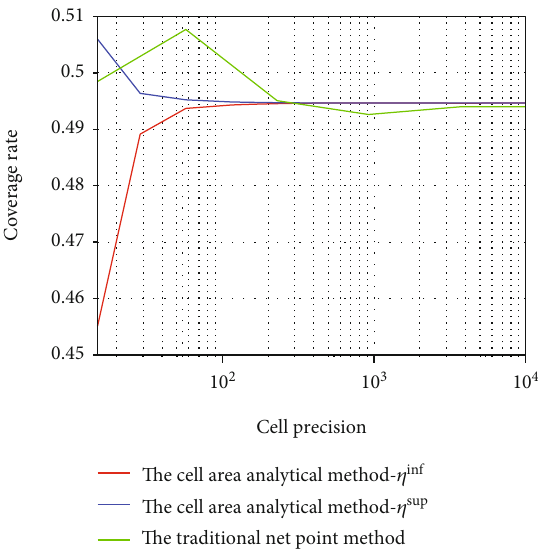
Figure 6: Results of coverage rate with an increase of the cell precision for